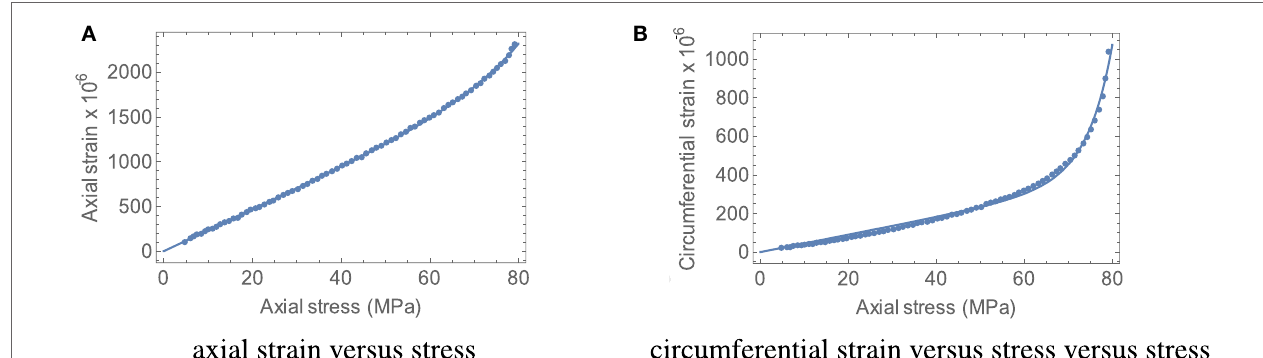
FigURe 8 | Non-linear relation between the stress and strain in the small strain range for concrete . Dots represent experimental data and the full line the theoretical fit based on a model belonging to the class equation (32). Data shown are for a concrete cylinder M10B1C2. Figures are taken from Grasley et al. (2015). (A) Axial strain versus stress. (B) Circumferential strain versus